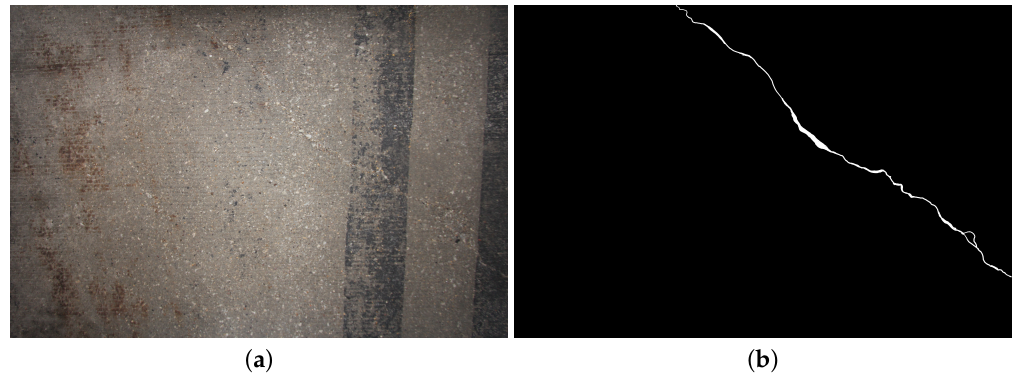
Figure 8. ( a ) Sample crack image and ( b ) annotated image from the Illinois Bridge